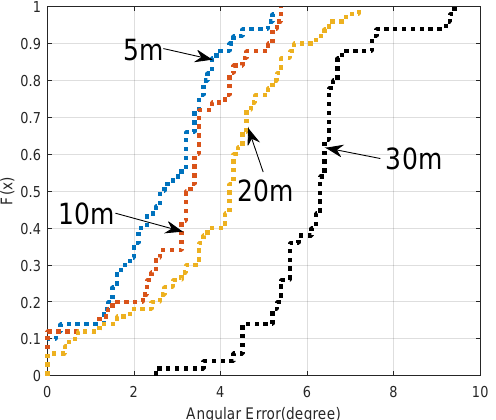
Figure 8. Cumulative distribution function (CDF) of the angular errors when using VUCA and L = 5 m, 10 m, 20 m, 30